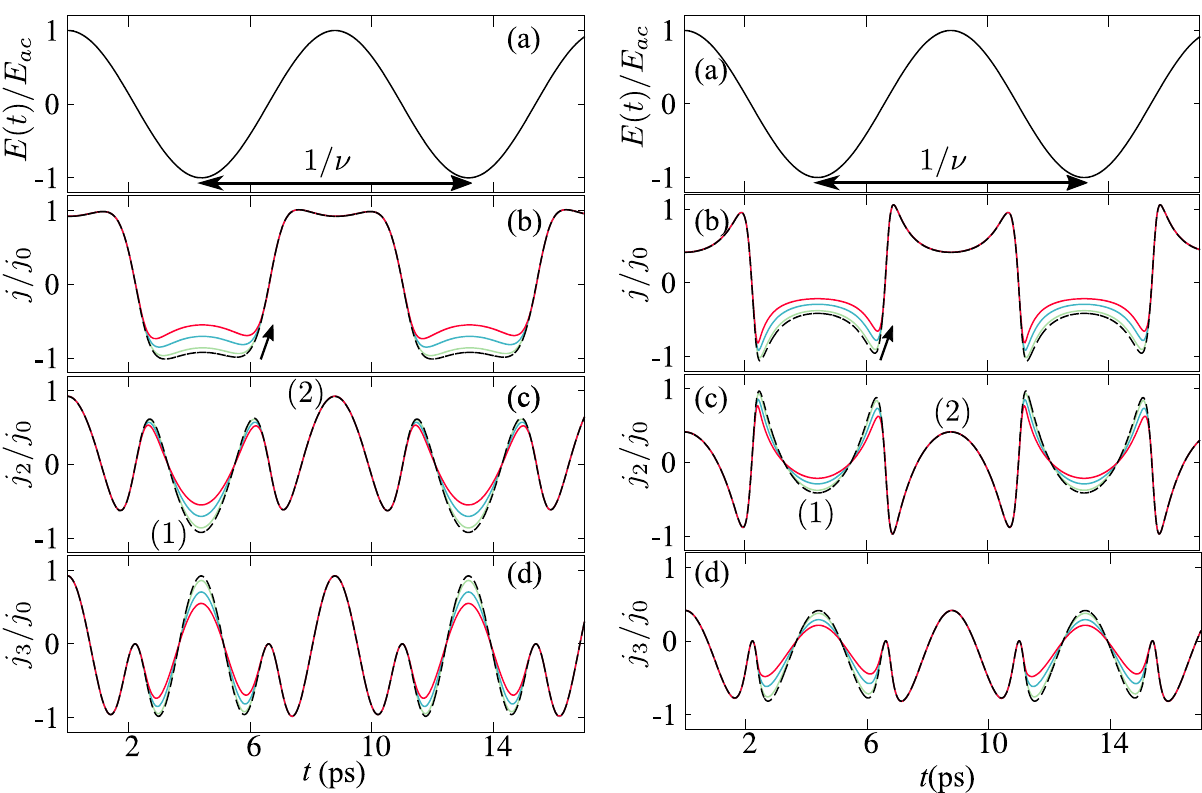
Figure 5: (Color online) Nolinear response of miniband electrons by considering asymmetric scattering processes. (a) The normalized electricfield[ E ( t )/ E ac ]whichcausesthetimedependentdrift.(b)The time-dependentcurrent j ( t )[seeEq.(3)]isdepictedovertwocyclesof the input fi eld E ( t ). (c) The second-harmonic j 2 ( t ) and (d) the third- harmonic current oscillations j 3 ( t ) calculated for different values of the asymmetry parameter δ (cid:2) 1 , 1 . 05 , 1 . 2 , 1 . 4. The labels (1) and (2) denoterelevantrelativeminimumandmaximumpoints.Inallcases, the value of the parameter α ≃ 27 corresponds to an electric fi eld with amplitude E ac = 0.75 E c and oscillating frequency ν (cid:2) 141 GHz. The arrow marks increasing asymmetry.